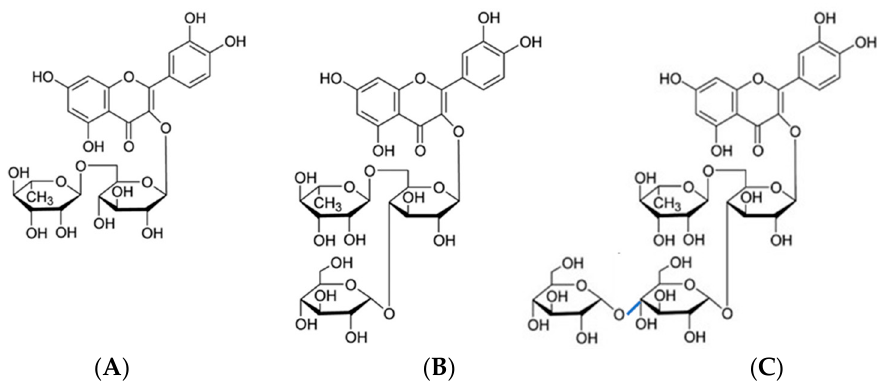
Figure 1. Chemical structures of rutin and its glycosylated compounds. ( A ) Rutin, ( B ) rutin mono- glucoside and ( C ) rutin di-glucoside.